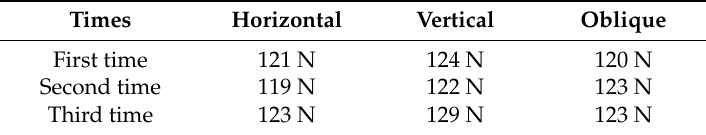
Table 2. Adsorption force of the magnetic wheel under di ff erent